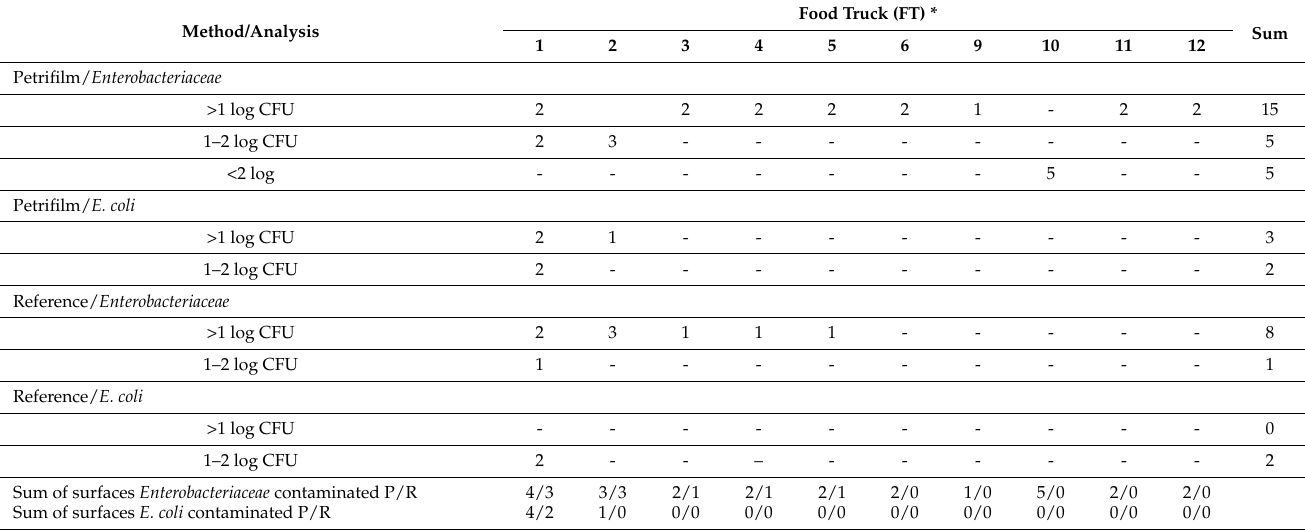
Table 4. Number of surfaces contaminated by faecal bacteria E. coli and Enterobacteriaceae enumerated in food truck outlets by growth culture